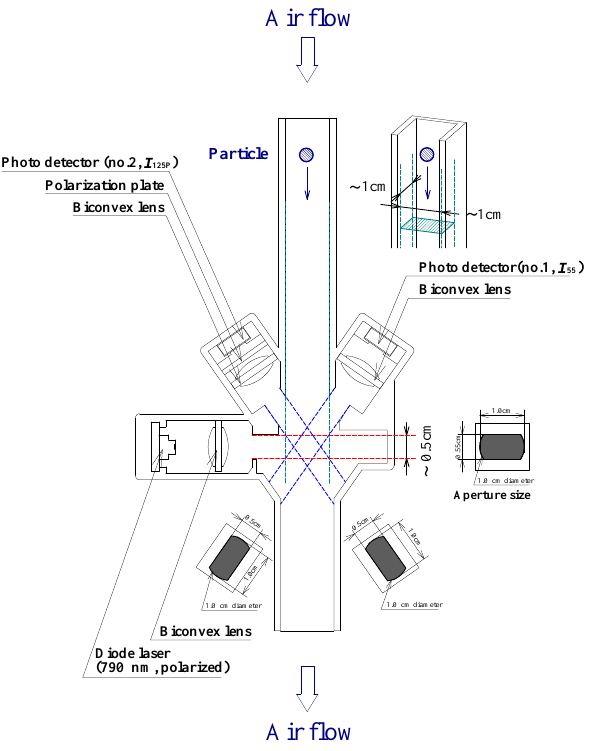
Figure 1. Schematic diagram of the CPS (the latest version). The diode laser, lenses, and two detectors (nos. 1 and 2) are shown, to- gether with the polarization plate for detector no. 2. Note that the laser device, scattering particle, and the two detectors are placed within the same plane, and the polarization of the incident light is parallel to this plane. Also shown is the information on the detec- tion area (with red, blue, and green dashed lines and with the views through the slits and